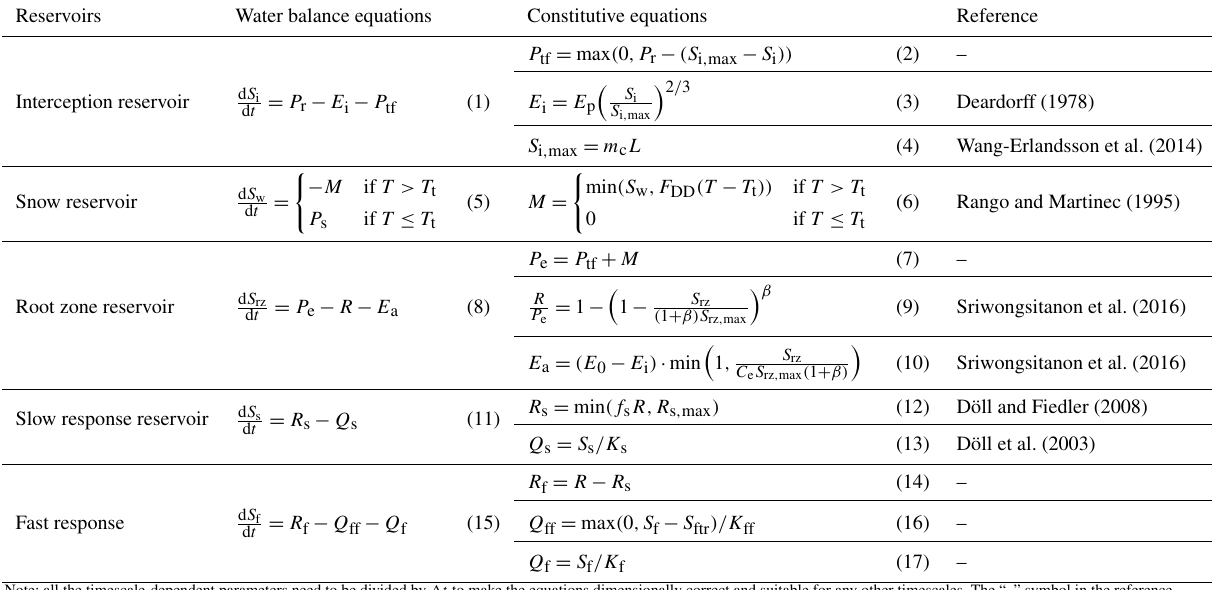
Table 1. Water balance and constitutive equations used in WAYS. Reservoirs Water balance equations Constitutive equations Reference